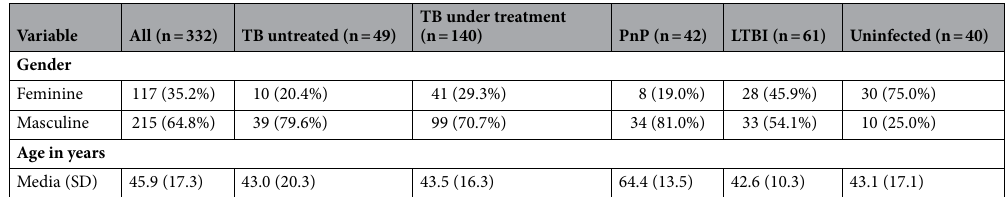
Table 1. Demographic information of the study population. Categorical variables expressed as a number of subjects (n) and percentage (%), and quantitative variables expressed as median and standard deviation (SD). TB, tuberculosis; PnP, pneumococcal pneumonia; LTBI, latent TB infection; Uninfected, individuals without